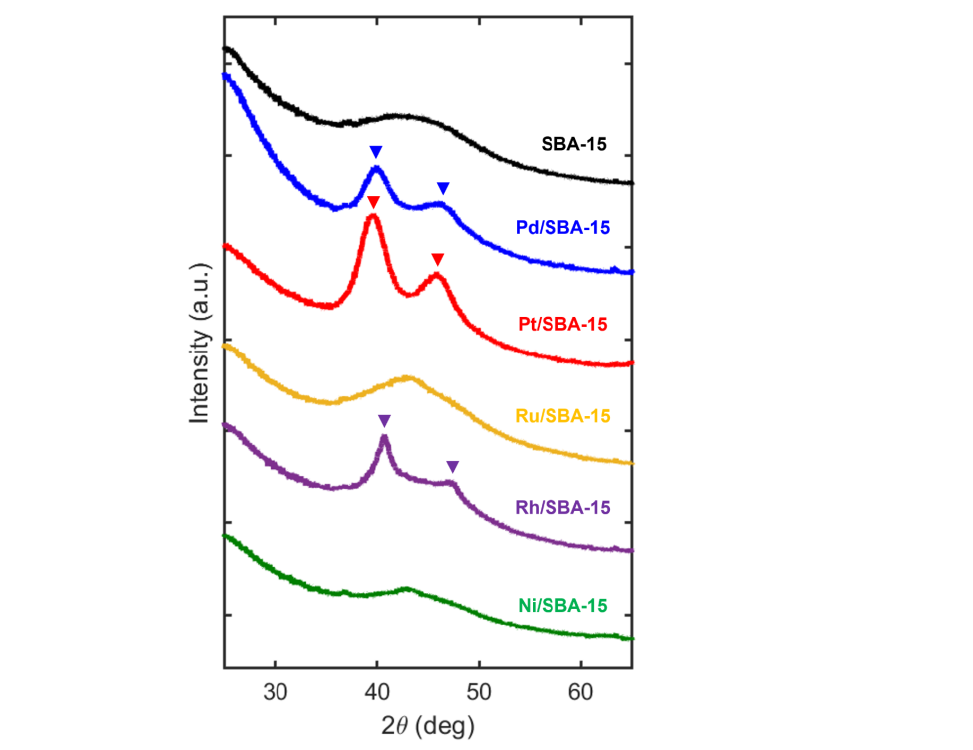
Figure 6. XRD patterns of SBA-15, Pd/SBA-15, Pt/SBA-15, Ru/SBA-15, Rh/SBA-15, and Ni/SBA-15. The blue, red, and purple triangles represent the characteristics peaks of the Pd, Pt, and Rh, respectively. Table 2. Dispersions and average particles size of metal on SBA-15 synthesized by ALD and WI.